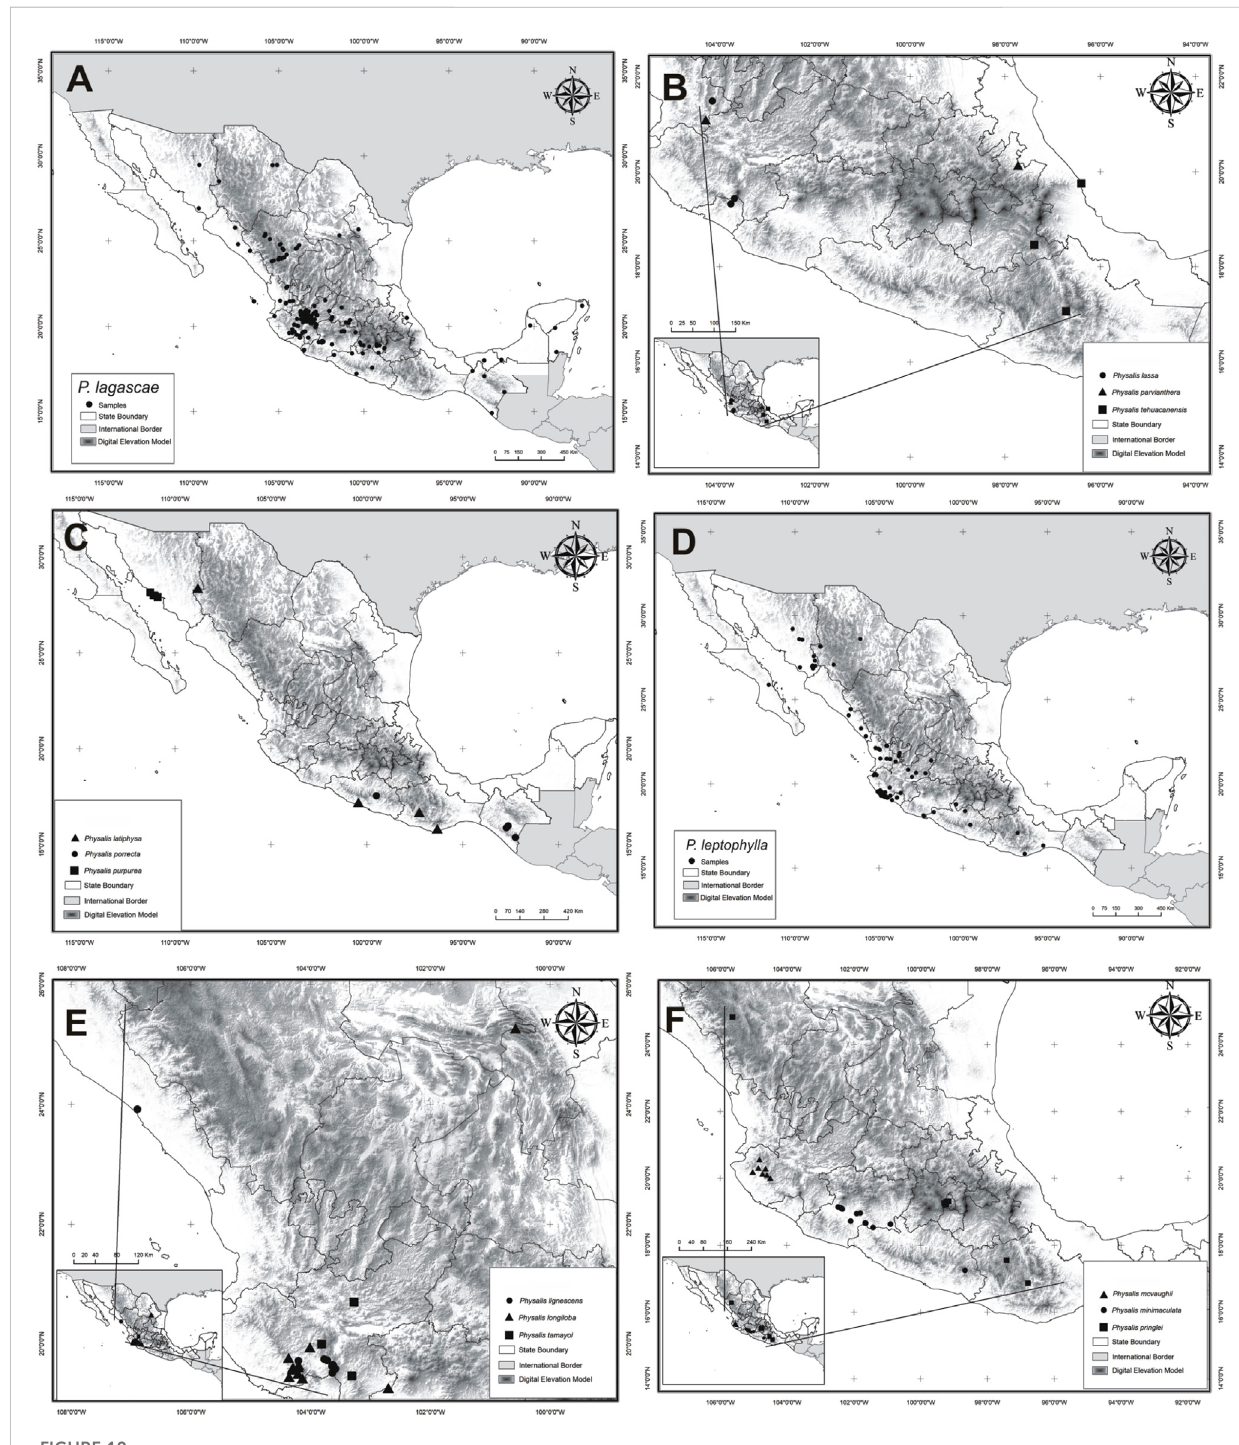
Geographic distribution of Physalis spp. (A) P. lagascae ; (B) P. lassa , P. parvianthera , and P. tehuacanensis ; (C) P. latiphysa , P. porrecta , and P. purpurea ; (D) P. leptophylla ; (E) P. longiloba , P. lignescens , and P. tamayoi ; (F) P. mcvaughii , P. minimaculata , and P.